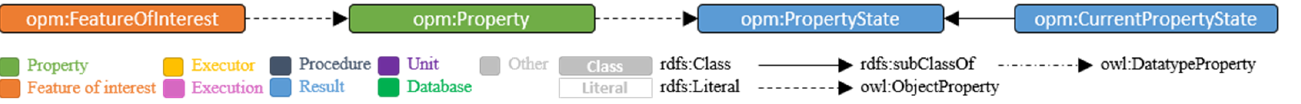
Figure 3. OPM’s pattern for versioning of properties.